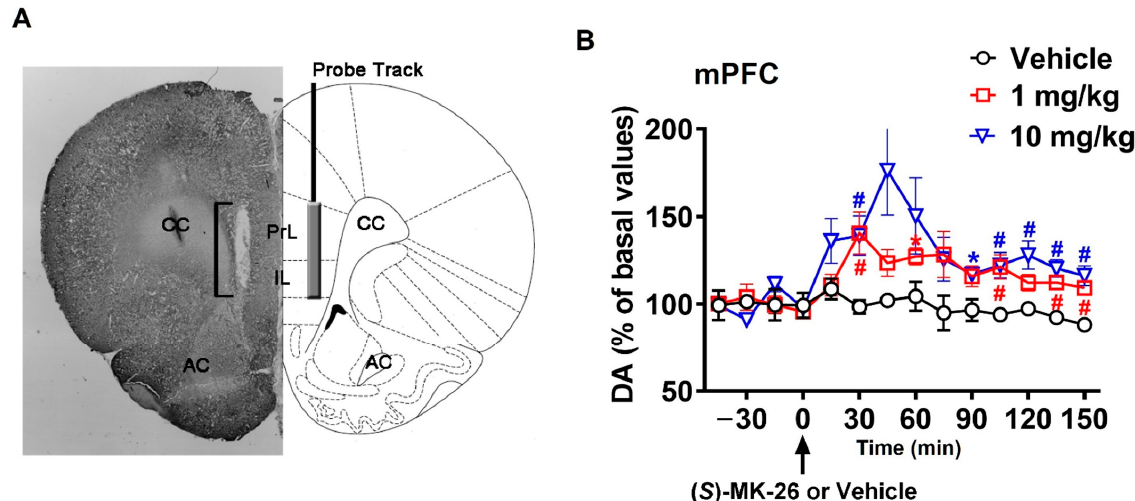
Figure 4. Treatment with ( S )-MK-26 enhanced brain extracellular concentration of dopamine in vivo. ( A ) Schematic representation of a coronal section of the rat brain (adapted from Paxinos and Watson, 2014 [45]) showing the track of the microdialysis probe in the PrL and IL portions of the mPFC. The square bracket in the microphotograph indicates the portion of the histological section showing the active part of the dialyzing membrane of the microdialysis probe. ( B ) Extracellular dopamine concentrations in the mPFC dialysates obtained from rats treated with ( S )-MK-26 (1 and 10 mg/kg) or vehicle. Rats stereotaxically implanted with a microdialysis probe aimed at the mPFC were placed individually into the experimental cage and perfused with the dialysis buffer. During the experiment, four dialysate aliquots were collected every 15 min and then vehicle or ( S )-MK-26 (1 or 10 mg/kg) was i.p. administered (indicated by the arrow in the figure) and 10 additional dialysate aliquots were also collected for dopamine determination. Data are charted as percentages (with 100% as the average of the last four dopamine basal values before treatment) with values expressed as means ± SEM of the measurements obtained by 3–5 rats per group. *: p < 0.05 compared to basal values (before treatment); #: p < 0.05 with respect to vehicle-treated rats (two-way RM-ANOVA followed by Tukey’s multiple-comparison test). Abbreviations: PrL, prelimbic area; IL, infralimbic area; AC, anterior commissura; CC, corpus